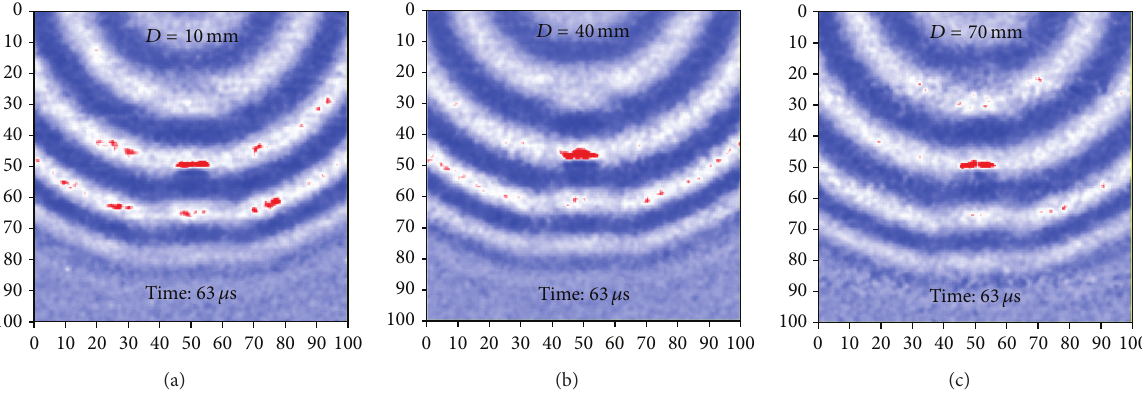
Figure 7: Ultrasonic wave fields at 63 𝜇 s in the glycerin-immersed plate according to the glycerin depth: (a) 𝐷 = 10 mm, (b) 40 mm, and (c) 70 mm (the same color scale for (a) to